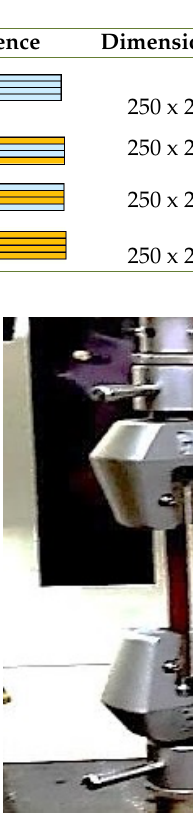
Table 1. Symbols, stacking sequence and dimensions of preferred composite laminates.